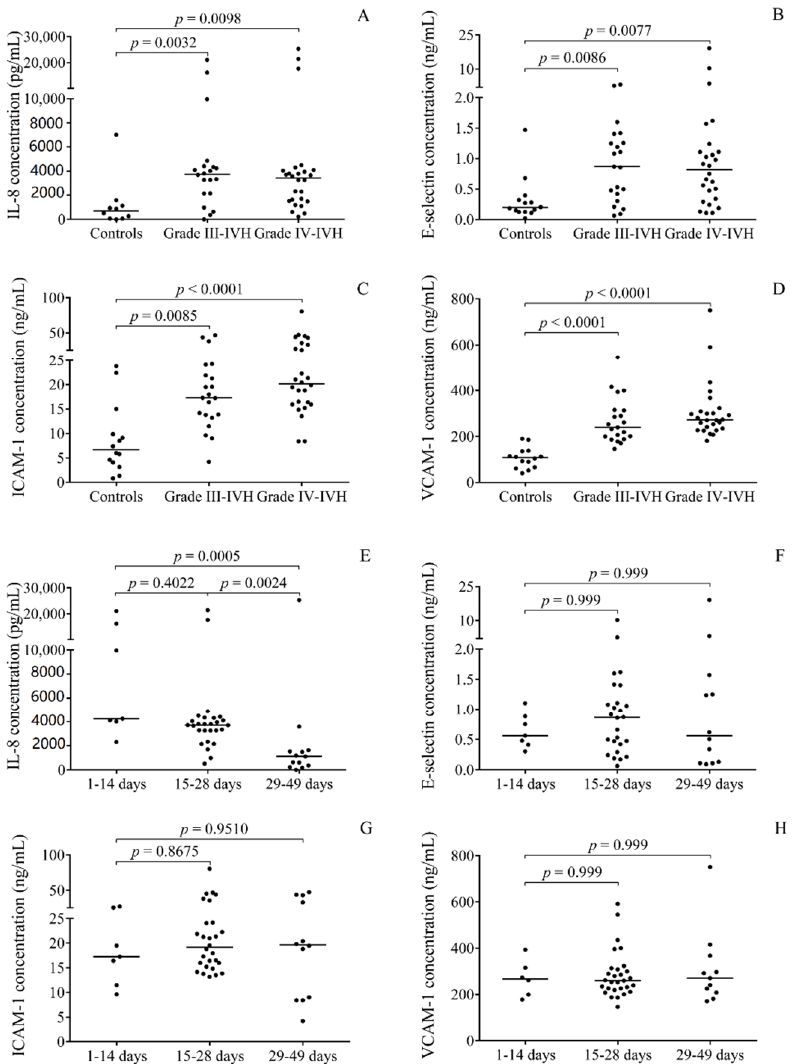
Figure 5. Augmented soluble IL-8 ( A ), E-selectin ( B ), ICAM-1 ( C ), and VCAM-1 ( D ) protein concentrations were detected by ELISA in baseline CSF samples of grade III ( n = 21) and grade IV ( n = 26) IVH vs. controls ( n = 14). Since CSF samples were obtained at different time points after the onset of IVH, the samples were subdivided into three groups: 1–14 days ( n = 7), 15–28 days ( n = 27), and 29–49 days ( n = 13). Only IL-8 ( E ) was significantly low at post-IVH days 29–49 and soluble adhesion molecules showed no change ( F – H ). Dots represent single values. Median values are depicted.